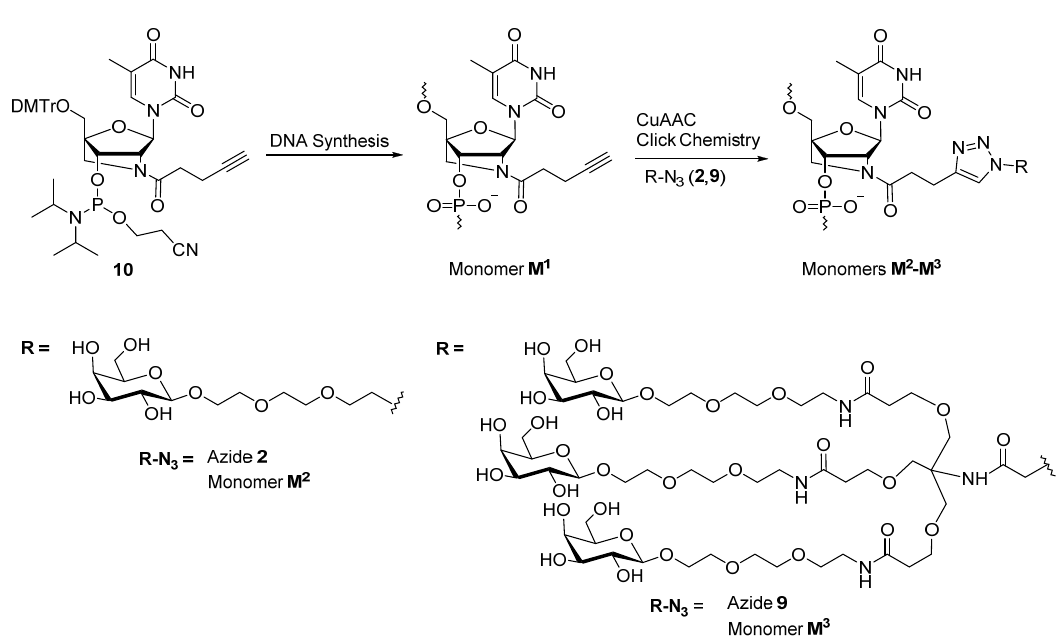
Scheme 3. Synthesis of alkynyl 2 ′ -amino-LNA monomer M 1 and incorporation of monomers M 2 and